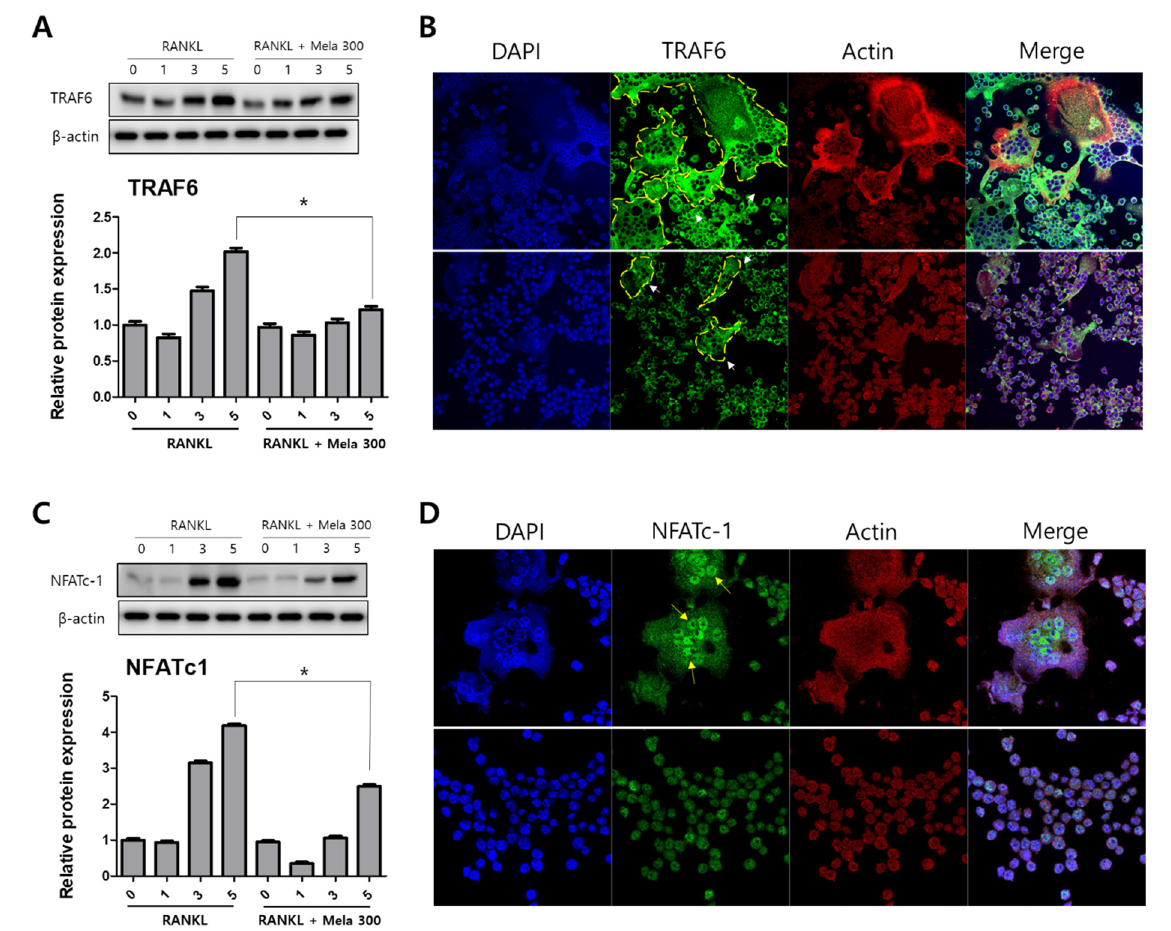
Figure 3. Reduction of TRAF6 and NFATc1 protein expression in RAW264.7 cells following RANKL and RANKL + melatonin treatment for 1, 3, and 5 days. ( A , C ) Protein expression of TRAF6 and NFATc1 according to western blot analysis. The expression data were normalized using β -actin. Values represent the means of three independent experiments ± SDs. RANKL alone treatment and RANKL + melatonin combination treatments were verified using a paired sample t -test (* p < 0.05). ( B , D ) Confocal immunofluorescence images of TRAF6 and NFATc1 (green) staining and nuclear (blue) and actin (red) counterstaining of RAW264.7 cells incubated for 5 days with RANKL and RANKL + melatonin, respectively.